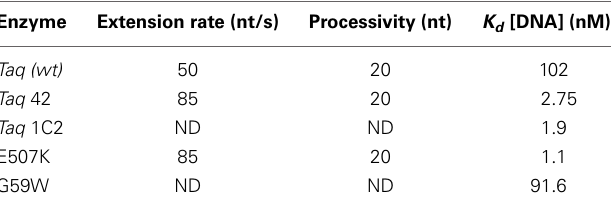
Table 2 | Kinetic parameters of wild-type and mutant Taq polymerases.